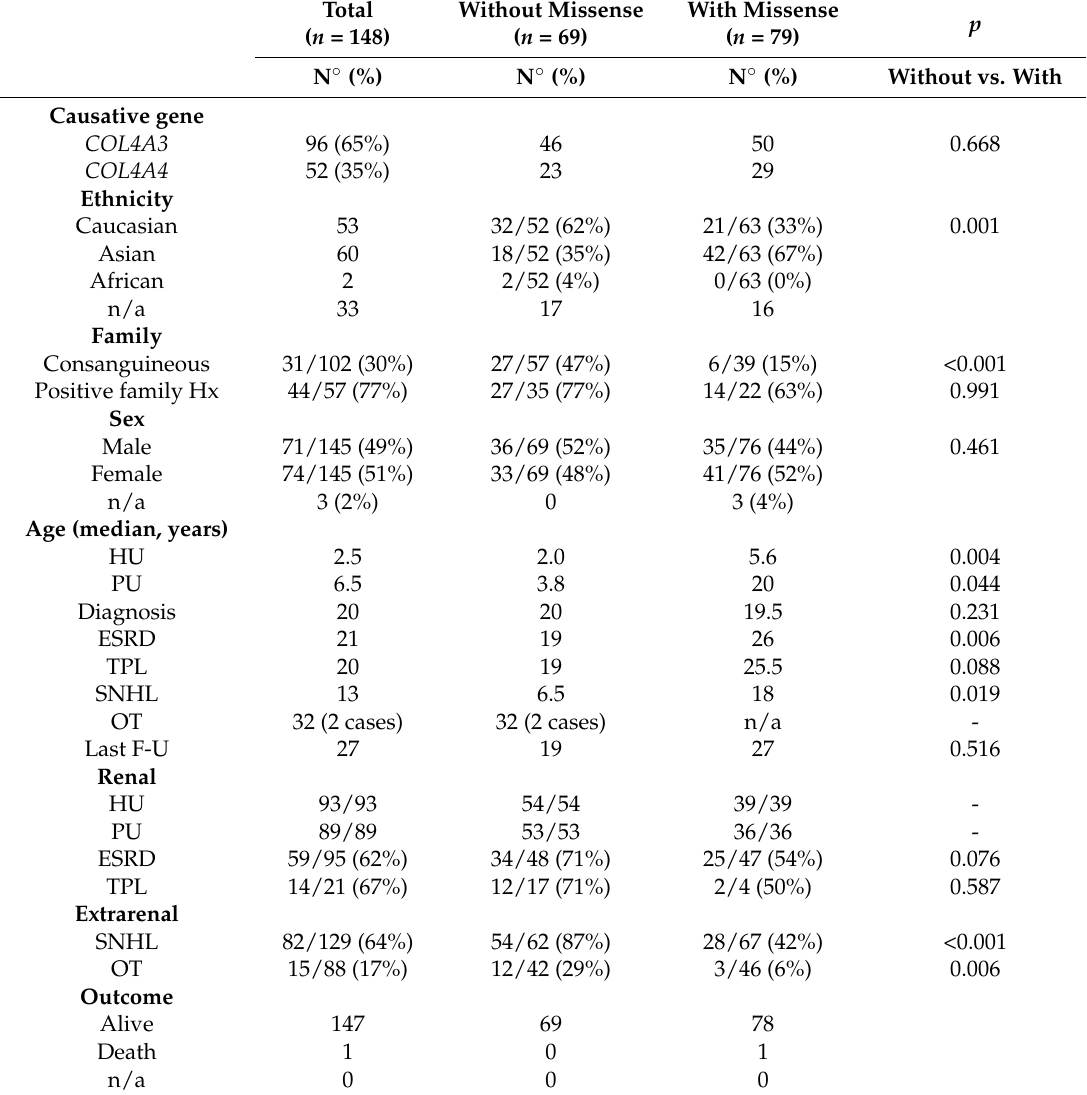
Table 2. Features of ARAS patients and comparison of groups with and without missense